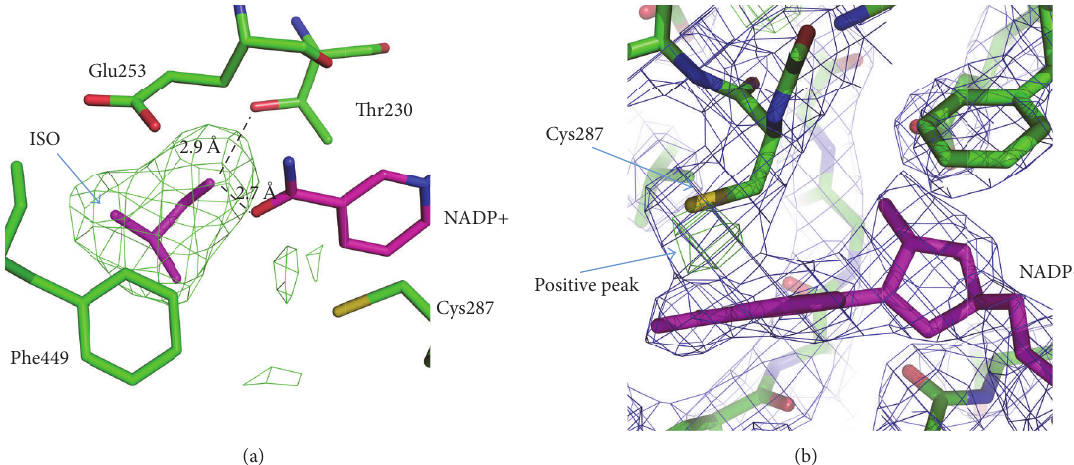
Figure 6: Active site in the complex of AlDHPyr1147 with isobutyraldehyde (ISO) and NADP+. The active site residues are in green. NADP+ and isobutyraldehyde are in magenta. The 2𝐹 obs − 𝐹 calc electron density map for the AlDHPyr1147 model is contoured at 1 𝜎 and colored blue. (a) The omit 𝐹 obs − 𝐹 calc electron density map for the model of the tertiary complex around the region of the substrate. The map is colored green and contoured at 3 𝜎 . (b) Positive electron density in the 𝐹 obs − 𝐹 calc electron density map for AlDHPyr1147, which is indicative of the possible second conformation of Cys287. The 𝐹 obs − 𝐹 calc electron density map for the AlDHPyr1147 model is contoured at +3.2 𝜎 and colored green. Hydrogen bonds are shown by dashed lines.